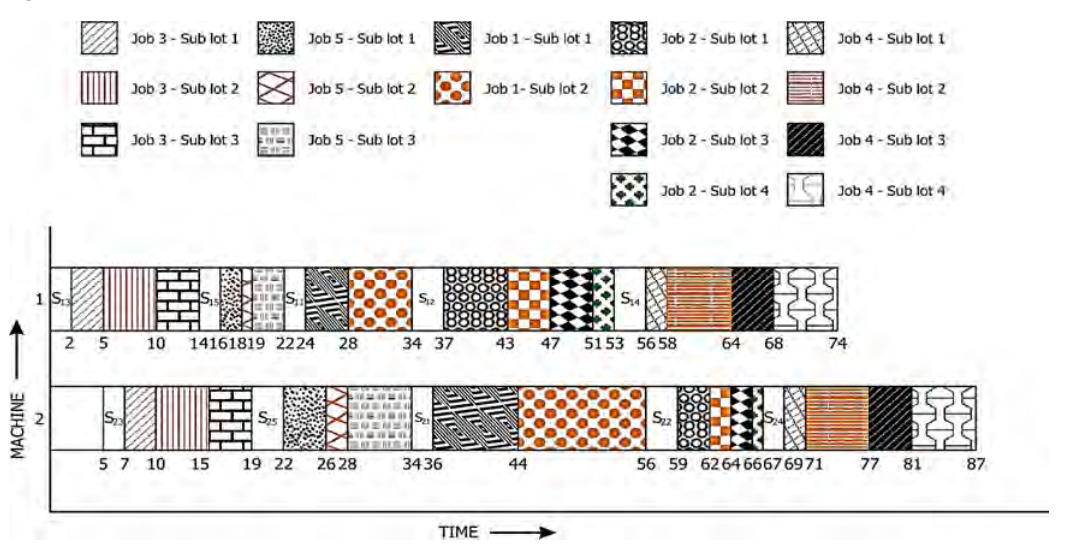
Fig.6 - Schedule for the sequence 3-5-1-2-4